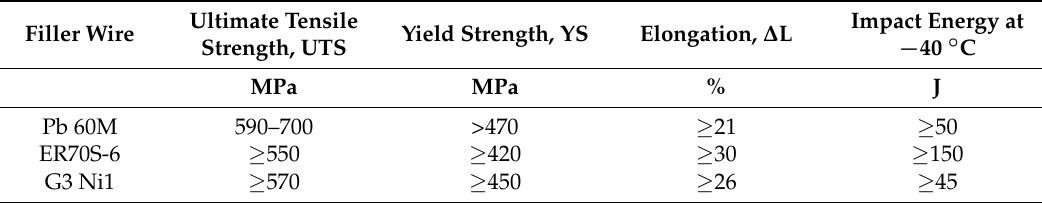
Table 7. Mechanical properties of the welding